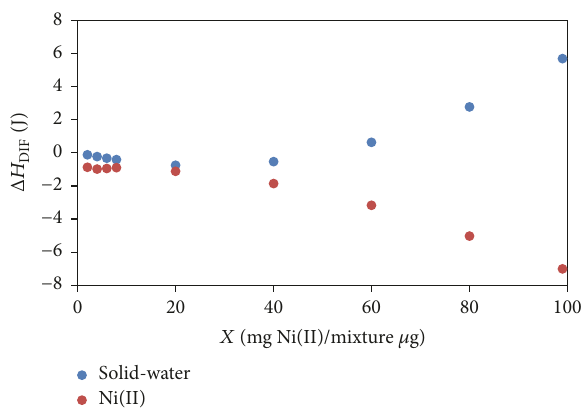
Figure 8: Change in the differential enthalpy (solid-solvent) and Ni(II) in function of the mass fraction of Ni(II) to the carbonized